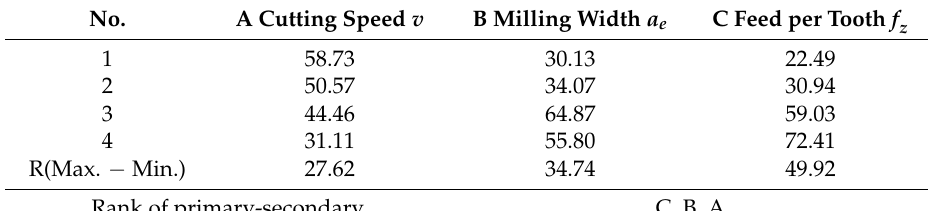
Table 8. Range table of F z